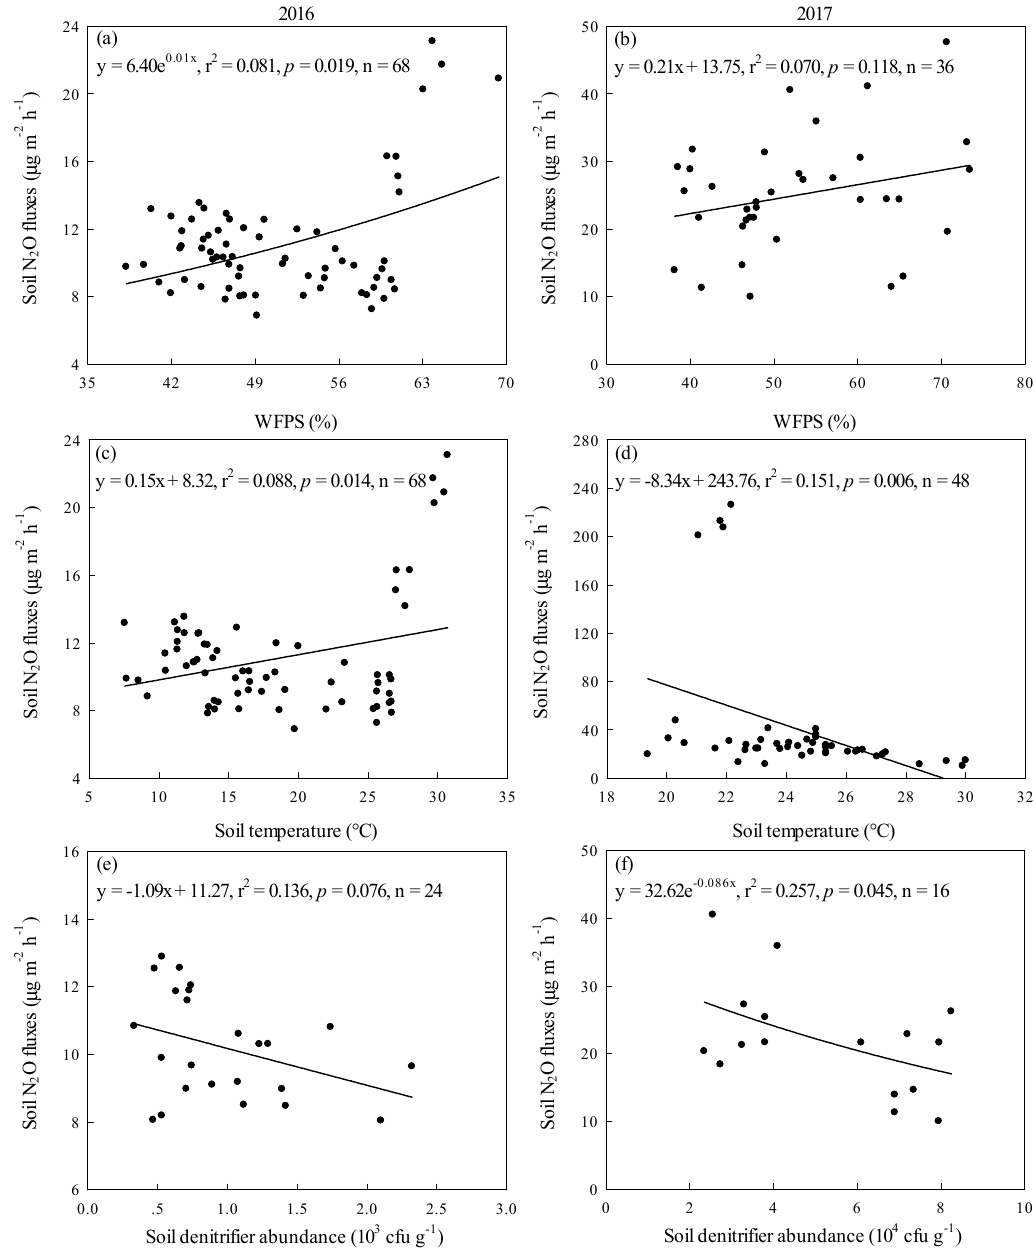
Figure 3. Relationships between soil N 2 O fluxes with WFPS in 2016 ( a ), WFPS in 2017 ( b ), soil temperature in 2016 ( c ), soil temperature in 2017 ( d ), soil denitrifier abundance in 2016 ( e ), and soil denitrifier abundance in 2017 ( f ).